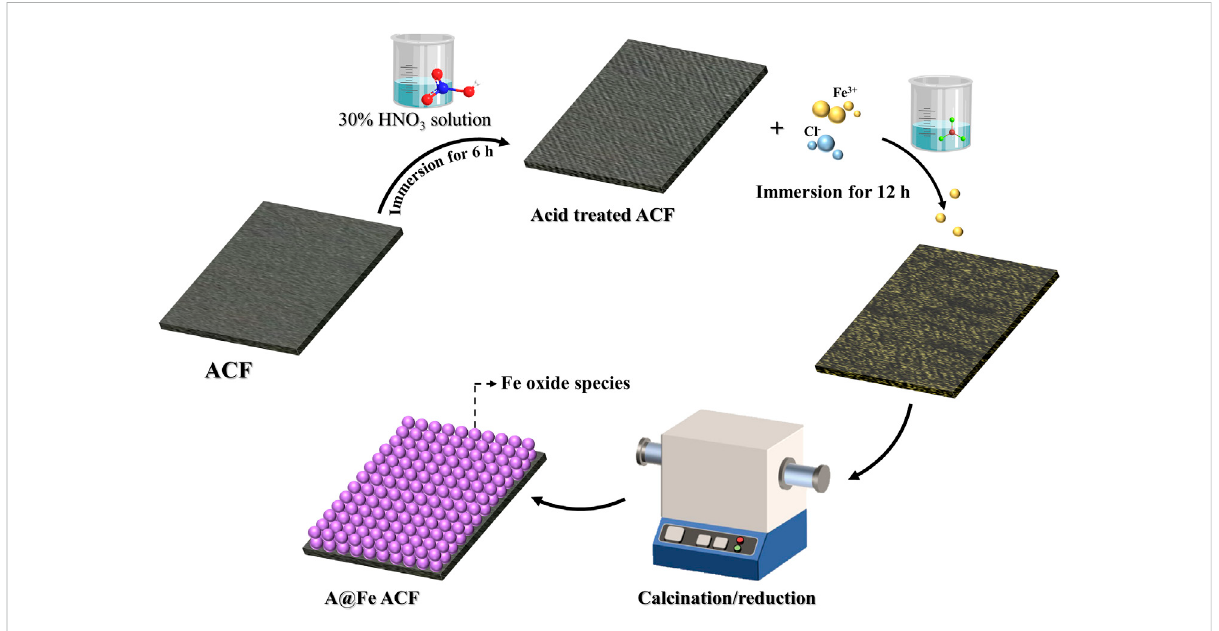
Preparation process of A@Fe-ACF electrode.